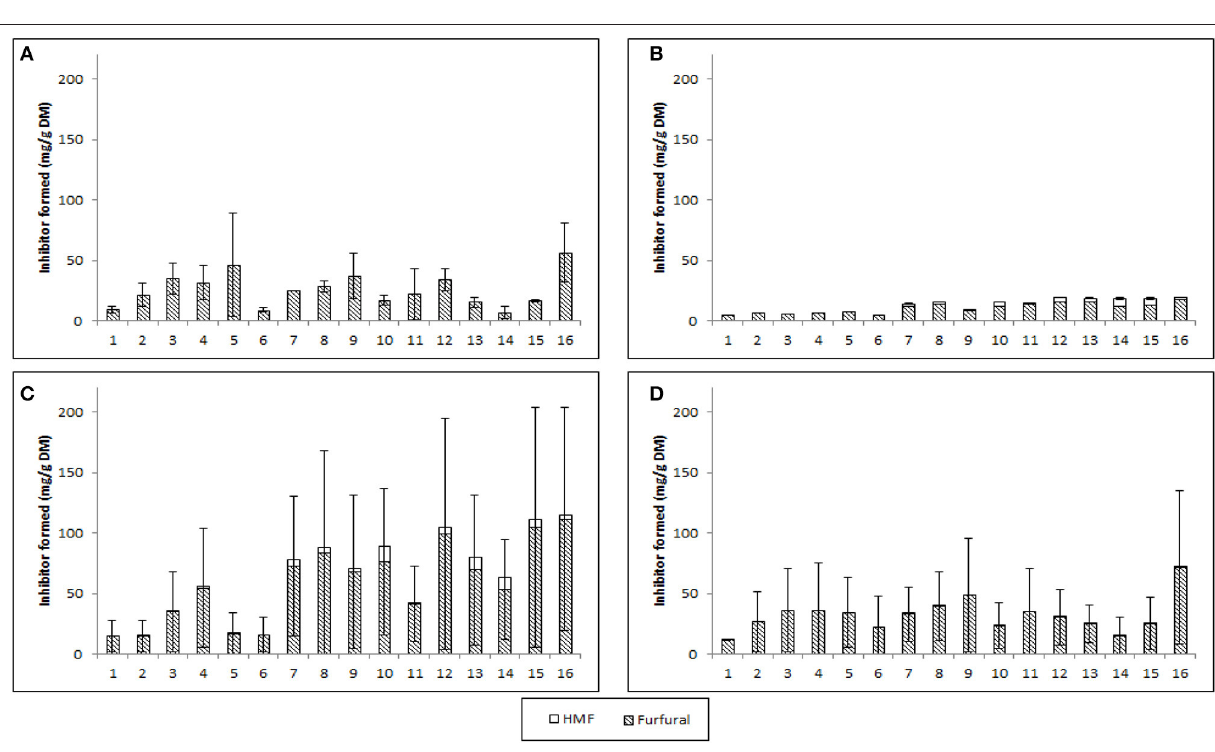
Frontiers in Energy Research |